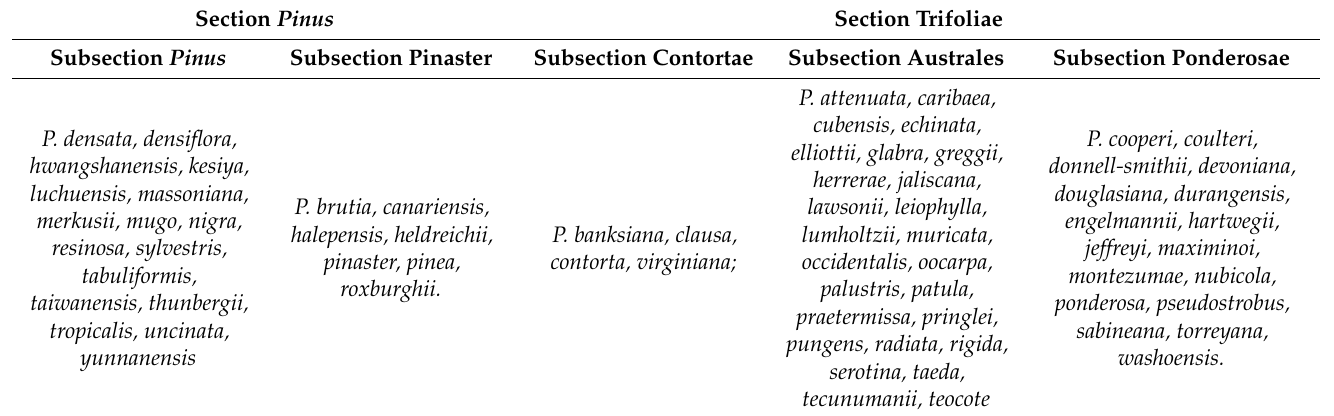
Table 2. Classification of subgenus Pinus